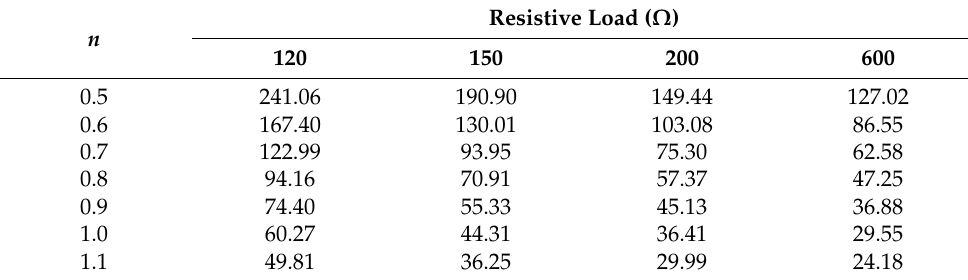
Table 2. Minimum capacitance values to self-induction of the